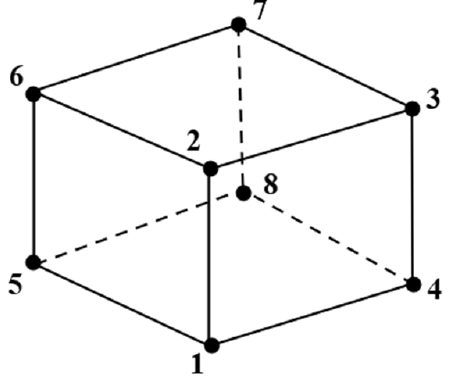
Figure 3. Eight-noded linear 3D brick solid element with reduced integration (C3D8R).